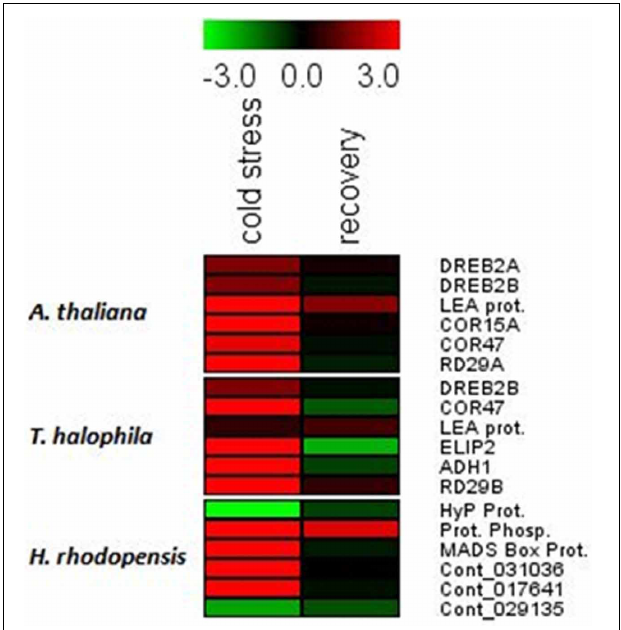
FIGURE 3 | Principal component analysis of metabolite profiles of leaves from A. thaliana (A), T. halophyla (T) and H. rhodopensis (H) under optimal growth condition (0) and following cold treatment (1) and subsequent recovery (2). Each point represents an individual biological replicate. Plotting of the first and second component is shown. The circles indicate the 95% confident